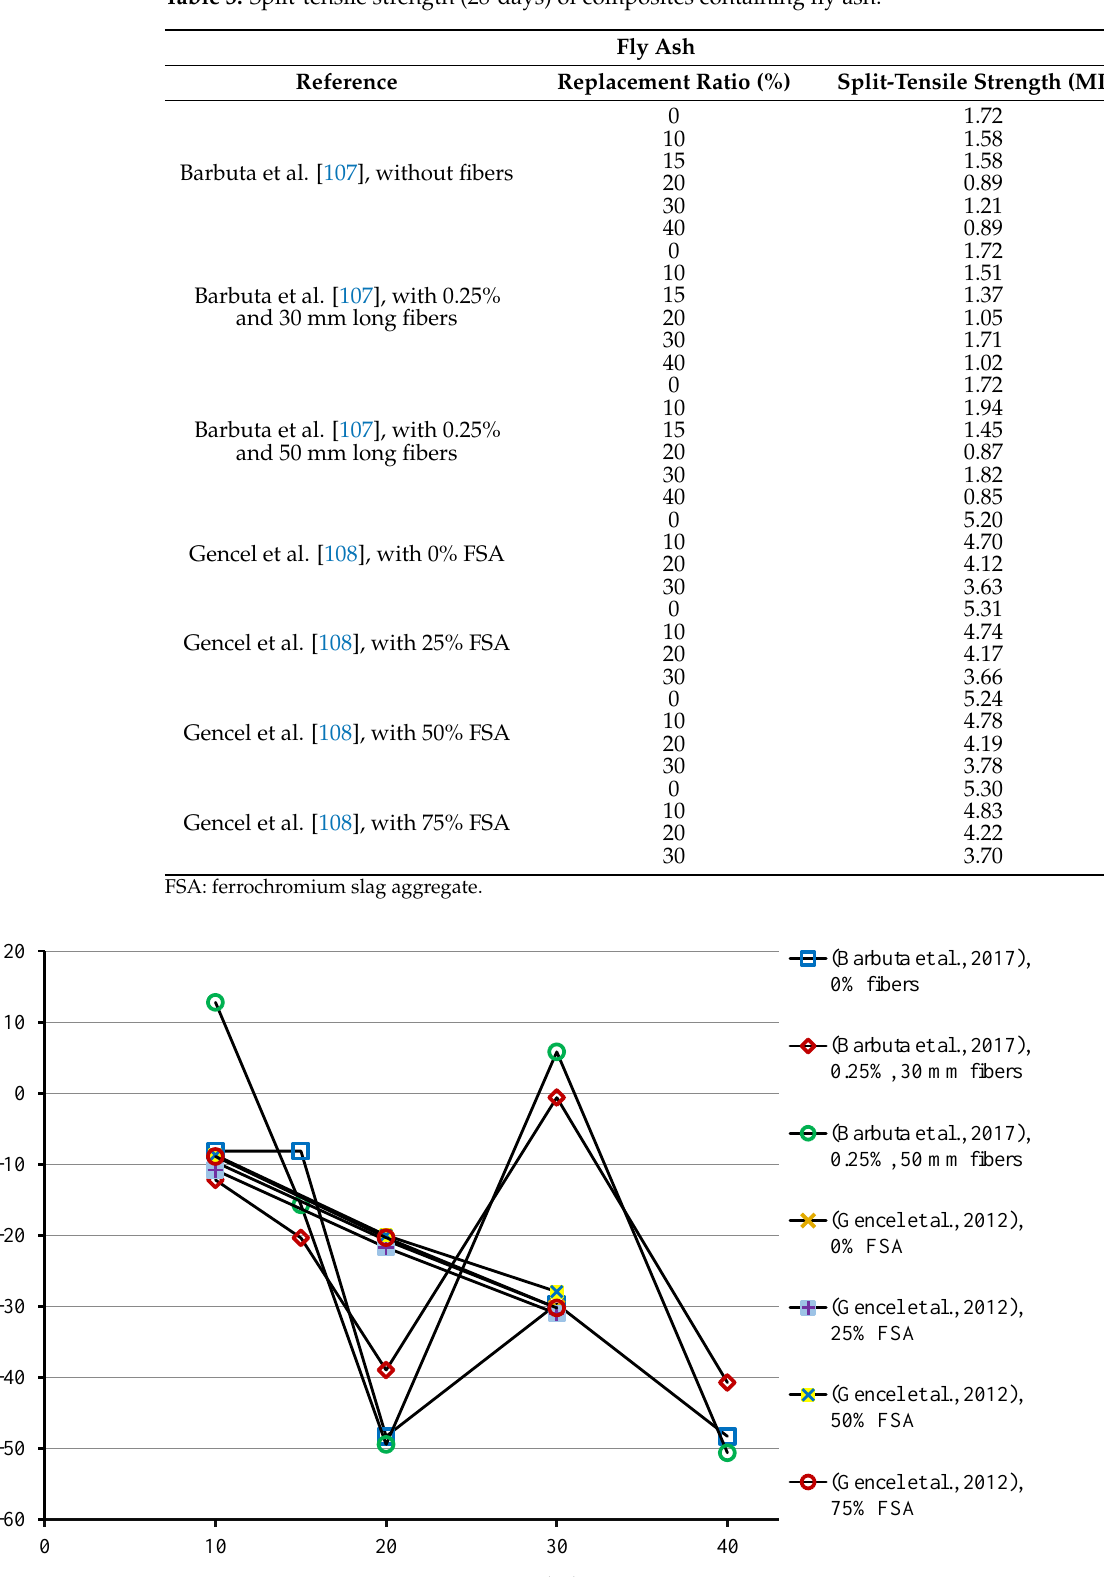
Table 3. Split-tensile strength (28-days) of composites containing fly ash.